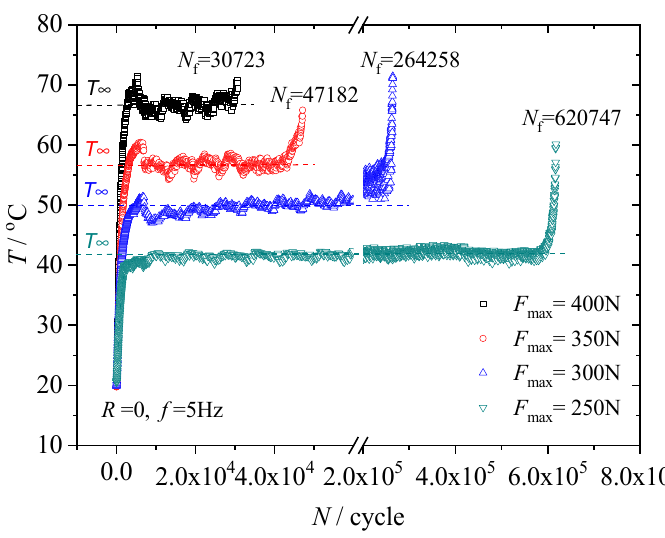
Figure 2. Surface temperature evolution of the specimen.